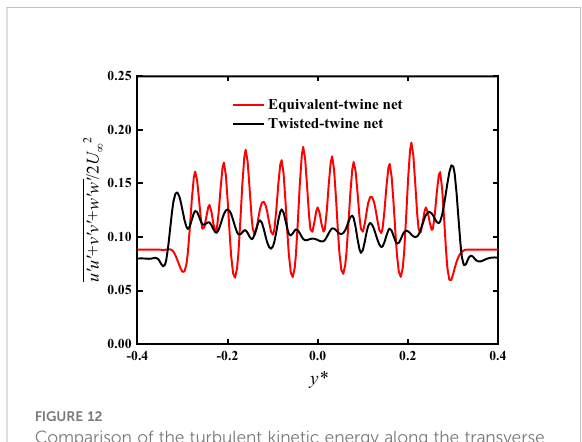
FIGURE 12 Comparison of the turbulent kinetic energy along the transverse direction of the equivalent-twine and the twisted-twine